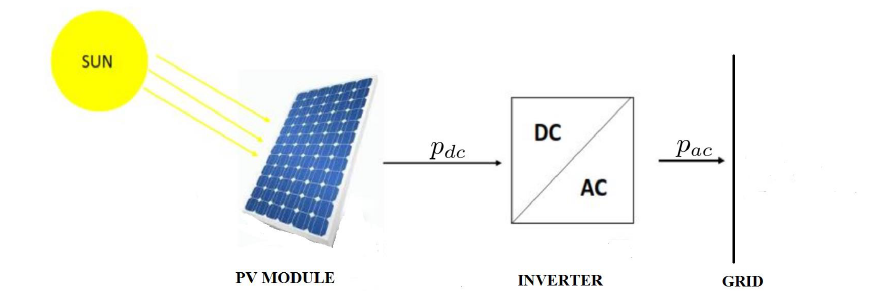
Figure 2. The setup of the PV unit and its interface with the distribution